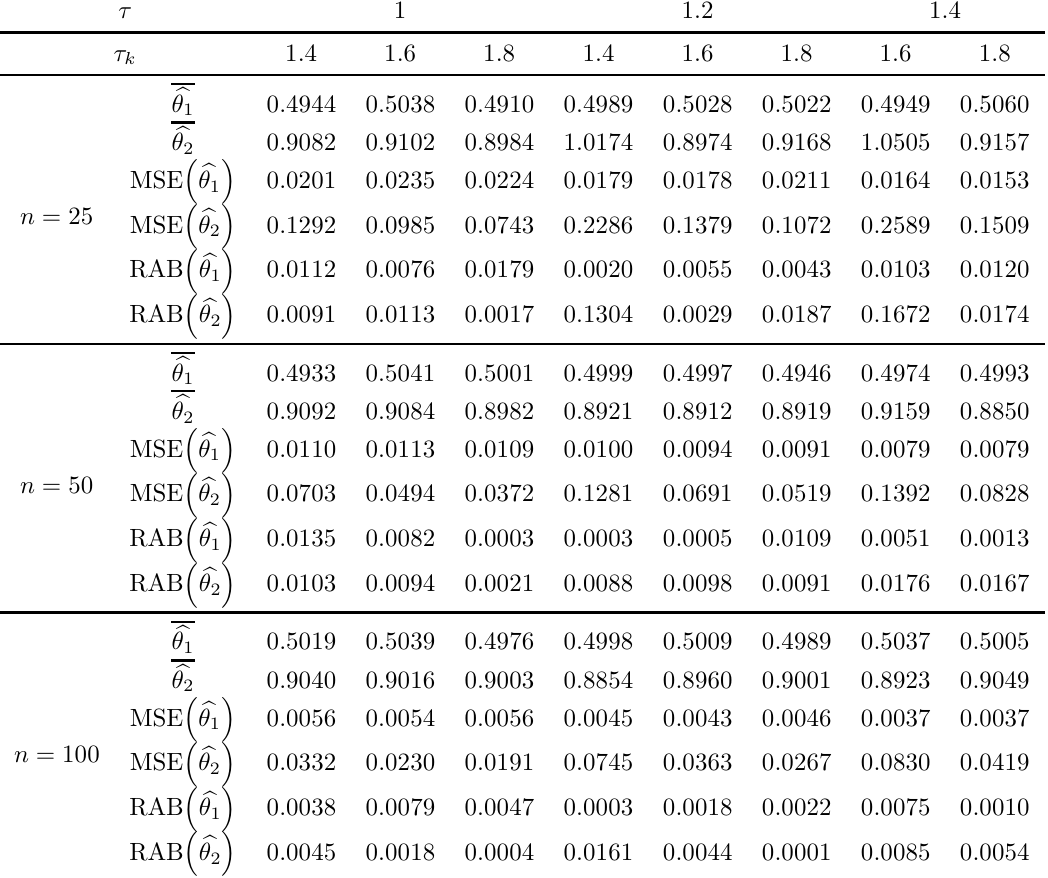
MLEs of θ 1 and θ 2 with corresponding MSEs and RABs for different values of n , τ and τ k based on 1000